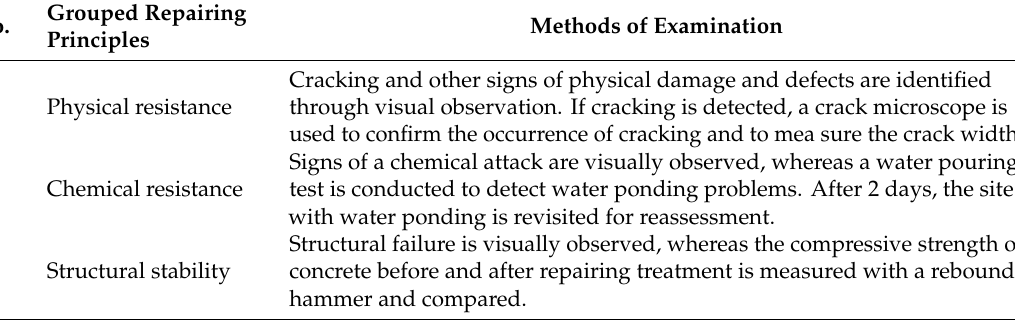
Figure 5. Flowchart to determine employable repairing principles. Table 1. Examination methods for di ff erent grouped repairing